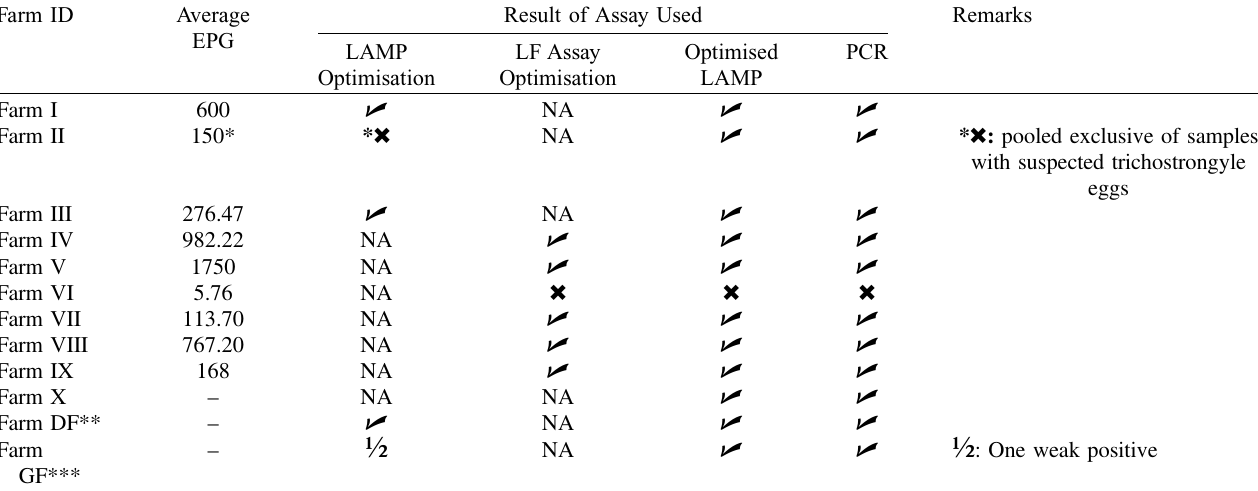
½ : One weak positive